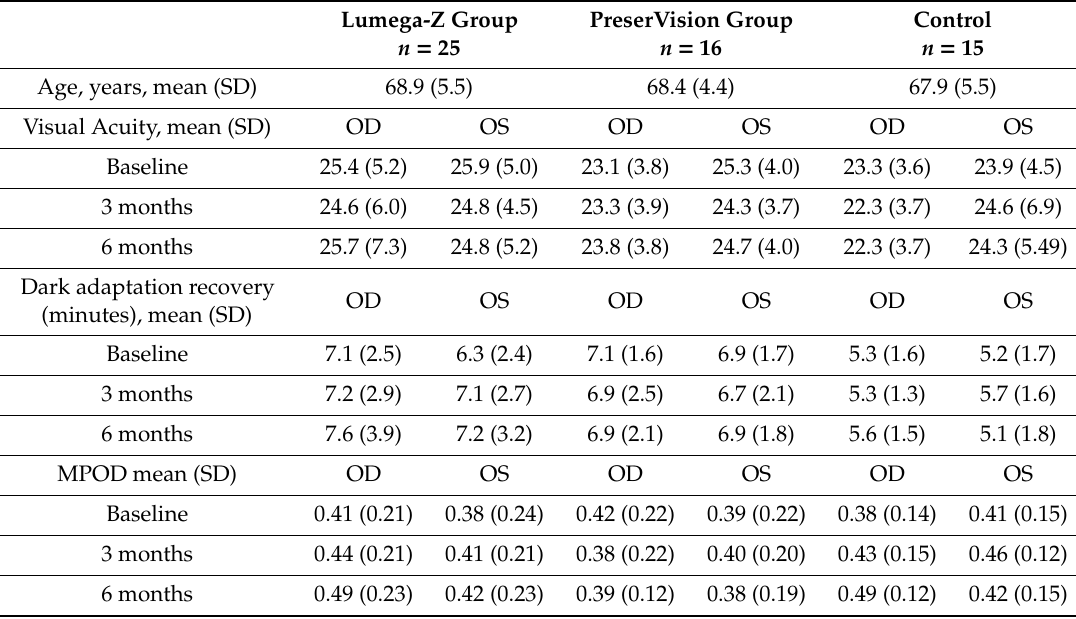
Table 1. Visual function measurements in various groups.